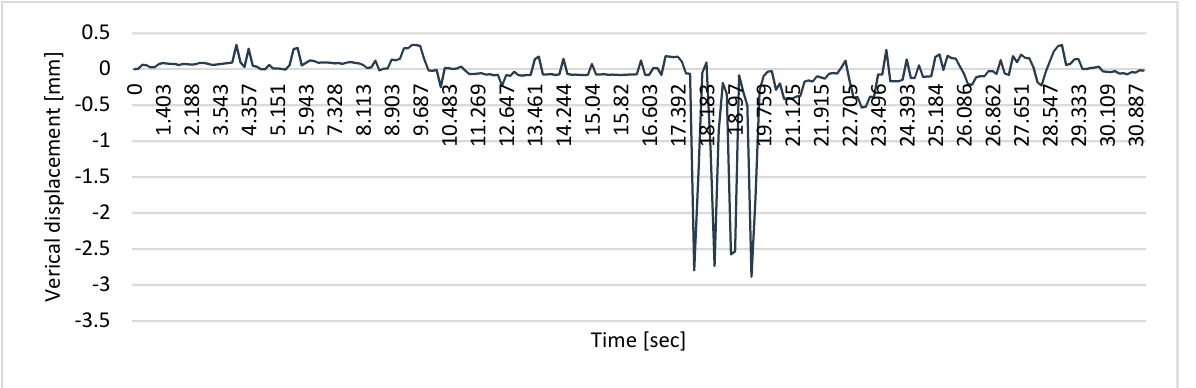
Figure 5. Results of a vertical displacement measurement with a Leica TS 50 RTS for a passenger train in motion.